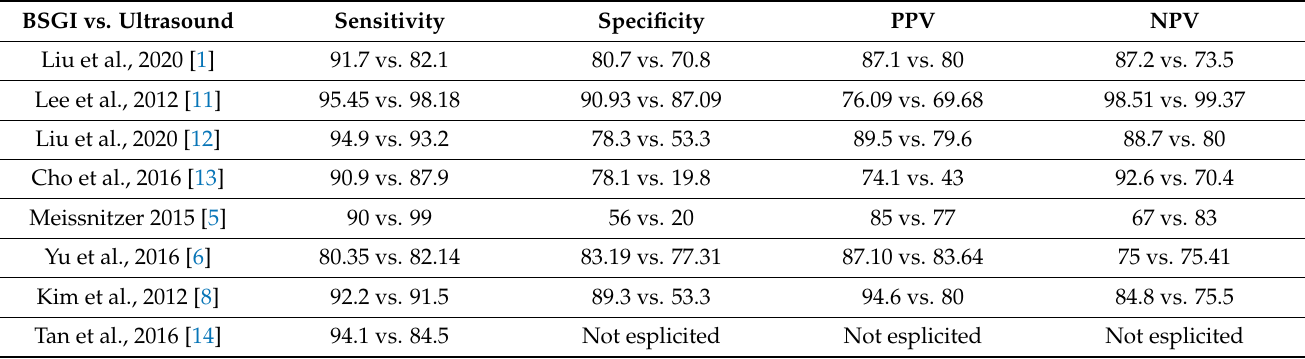
Table 3. Sensitivity, specificity, PVV and NPV for BSGI and ultrasound in the included studies.